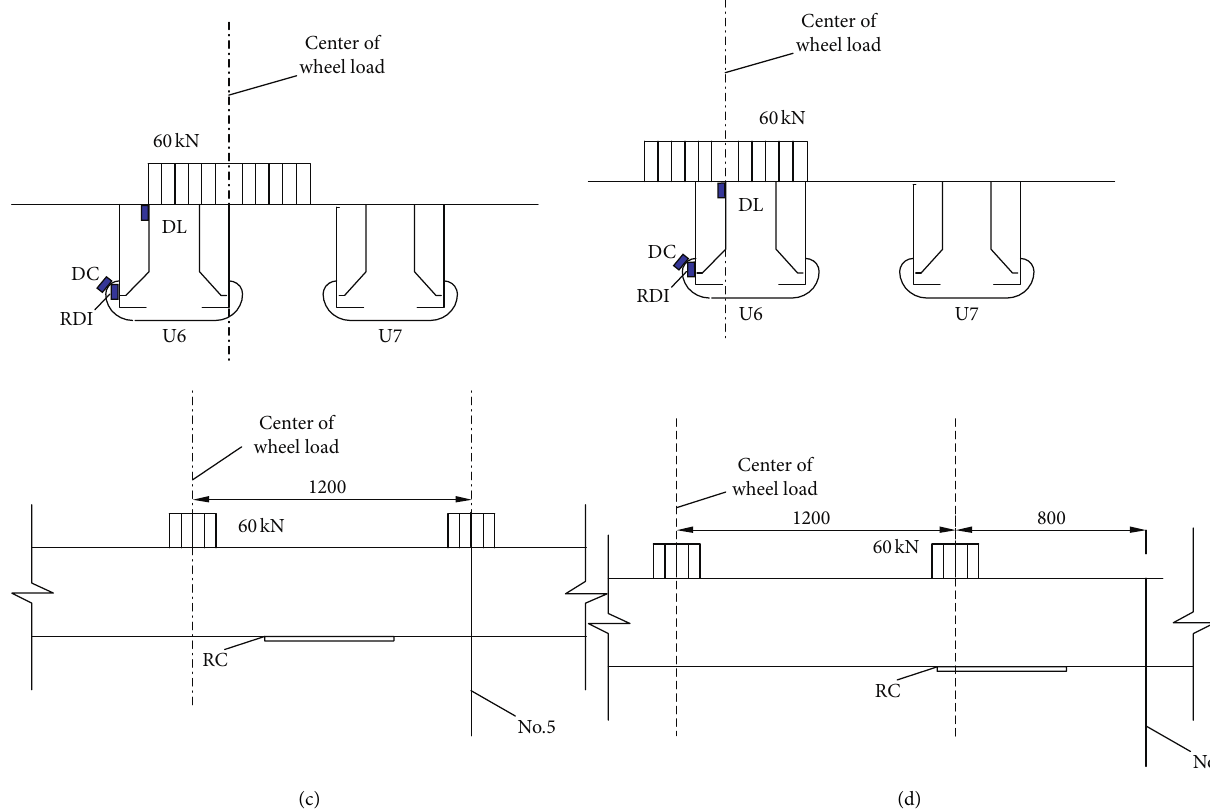
Figure 13: The most unfavorable loading position of each fatigue detail. (a) DC and RDI (condition 1). (b) RD. (c) DL (condition 2). (d)